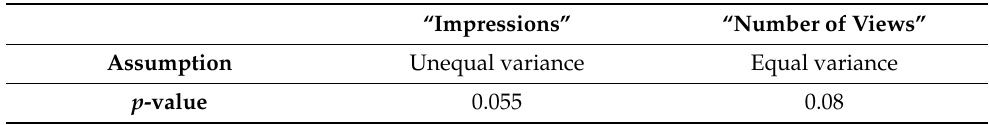
Table 5. Results of the t -test for the two normally distributed variables “Impressions” and “Number of views”.